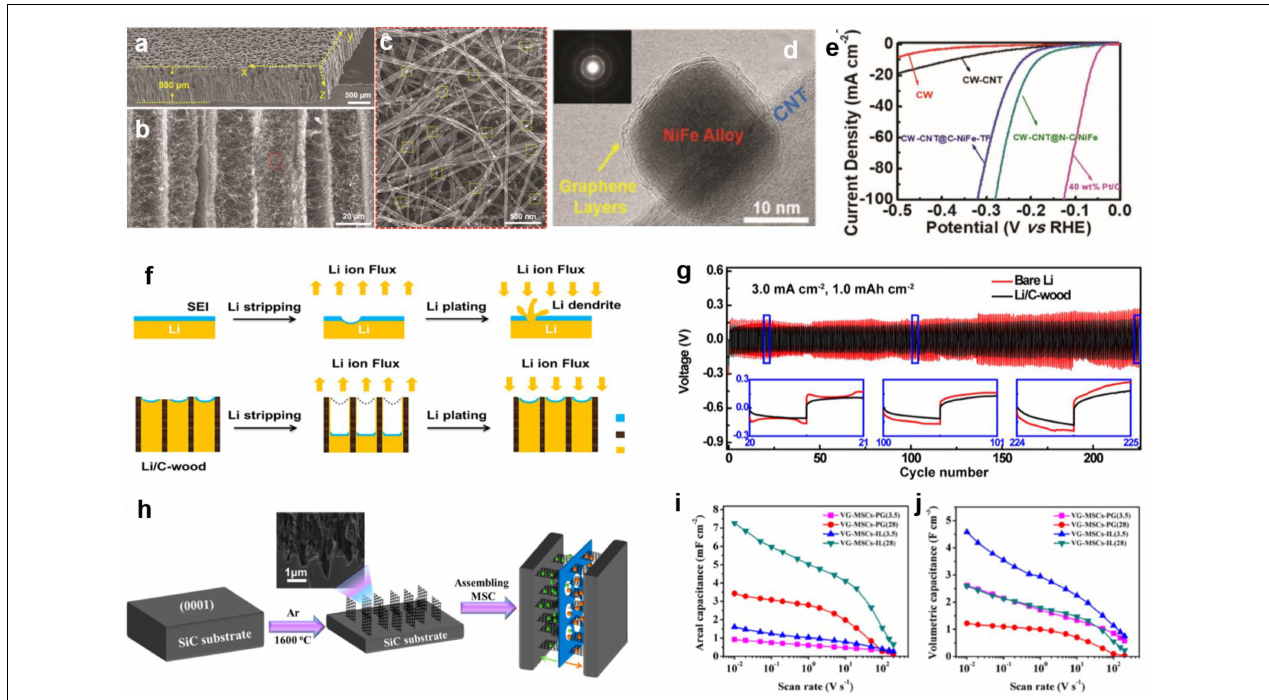
FIGURE 2 | (a–d) Morphology of the CW-CNT@N-C-NiFe. (a–c) : SEM images of CW-CNTs@N-C-NiFe (d) TEM image of CW-CNTs@N-C-NiFe, it shows the NiFe alloy nanoparticle which is inset in CNT and encapsulated by the few graphene layers) (e) LSV curves of the CW, CW-CNTs, CW-CNTs@C-NiFe-NF, CW-CNTs@N-C-NiFe, and commercial 40 wt% Pt/C electrodes (source: Li Y. et al., 2018). Reproduced by permission of WILEY-VCH Verlag GmbH & Co. KGaA, Weinheim https://doi.org/10.1002/aenm.201801289. (f) Li stripping/plating of bare Li metal electrodes and Li/c-wood electrodes. (g) Voltage profiles of bare Li metal and Li/c-wood cell at 3 mA · cm - 2 , Li/c-wood cells exhibited smaller voltage and long-term cycling stability (source: Zhang Y. et al., 2017). Reproduced by permission of American Chemical Society https://doi.org/10.1073/pnas.1618871114. (h) VG films derived from the SiC substrates to form VG-MSCs. (i,j) Areal/volumetric capacitance of different VG-MSCs (PG means using H 2 SO 4 /PVA as gel electrolyte, IL means using EMIMBF 4 as liquid electrolyte) (source: Zheng et al., 2017). Reproduced by permission of American Chemical Society